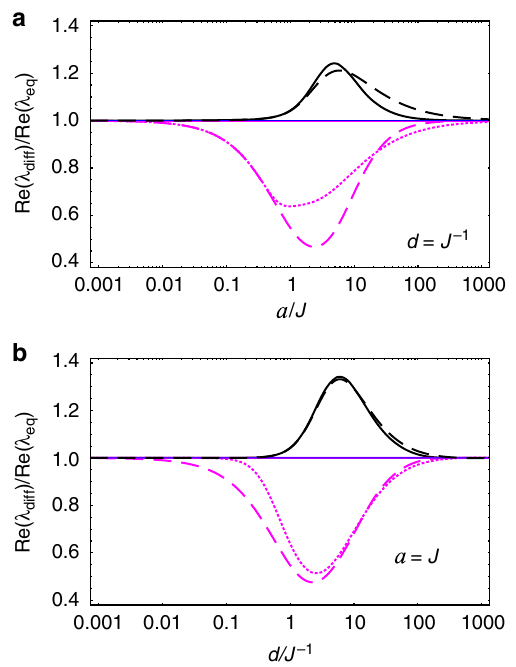
Fig. 6 Ratio between the relaxation/decoherence rates for different scenarios. For each decaying mode ^ ρ k of the spin system, we plot (using the same style code as in Fig. 2) the ratios Re( λ diff )/Re( λ eq ), where Re( λ diff ) is the decay rate in the case of spins with different proper accelerations and Re( λ eq ) is the decay rate in the case of spins with equal proper accelerations. In ( a ) the ratios are plotted as functions of spin-A ’ s proper acceleration a (for fi xed d = J − 1 ), while in ( b ) the ratios are plotted as functions of the spins ’ separation d (for fi xed a = J